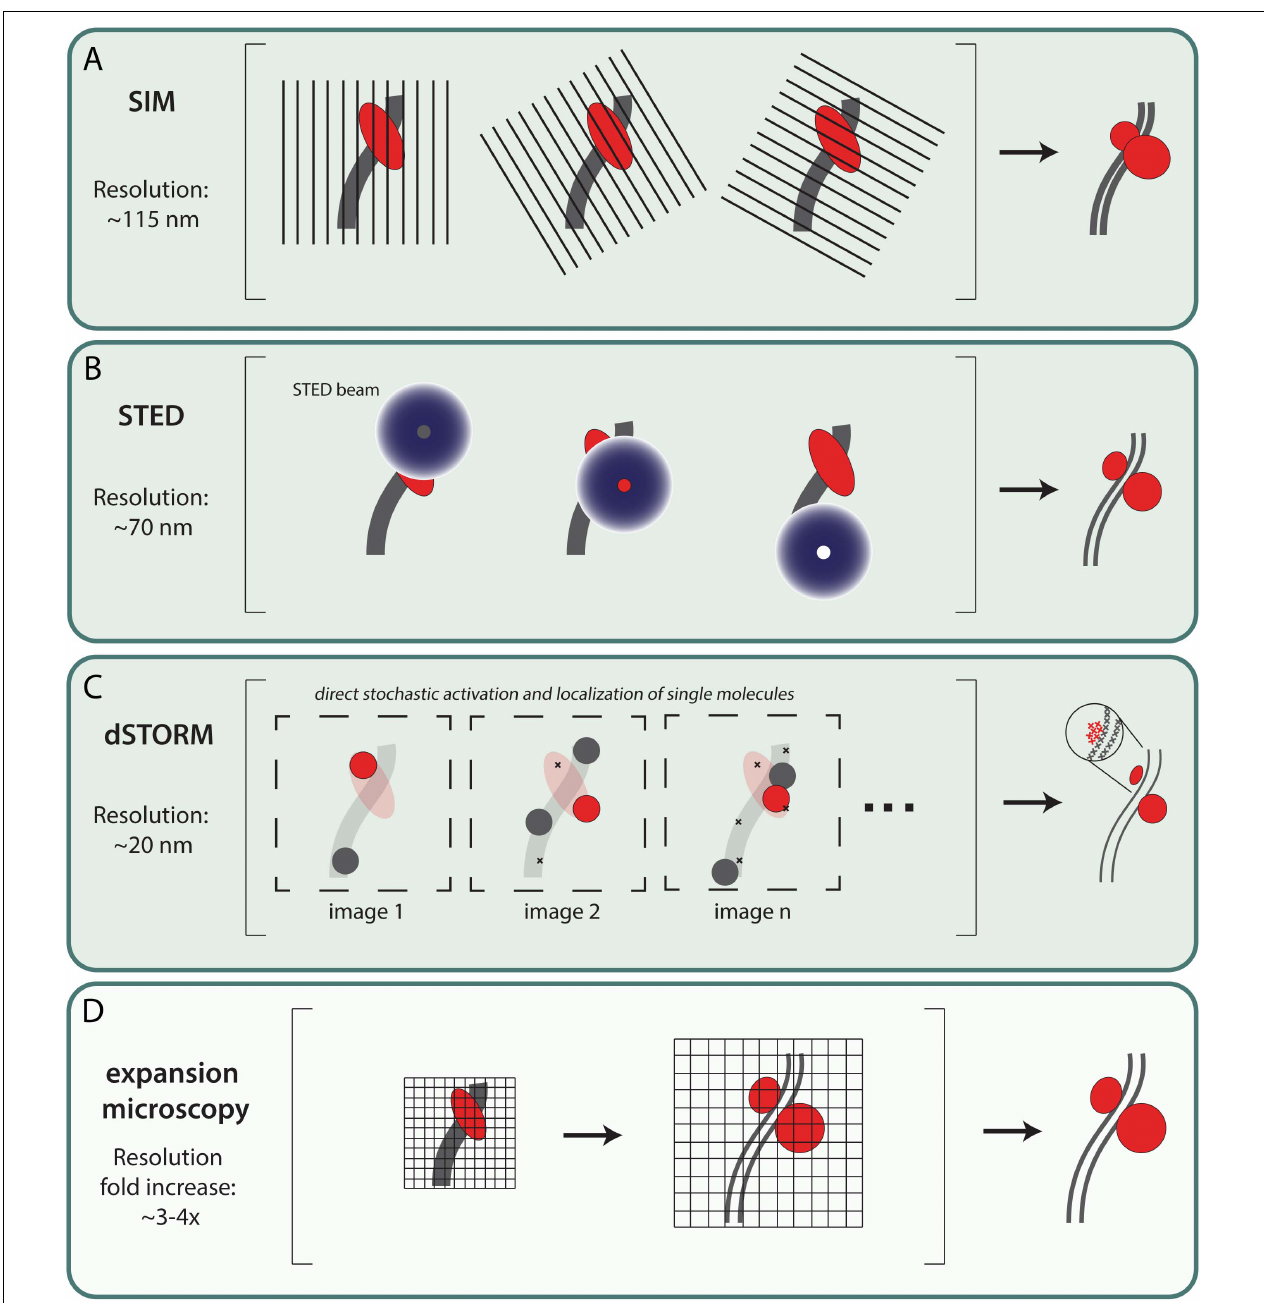
FIGURE 1 | Most commonly used fluorescent super-resolution microscopy techniques in meiosis research. (A) Structured illumination microscopy (SIM) – SIM uses a movable diffraction grating in combination with widefield microscopy. By exciting the sample and simultaneously translating and rotating the grid, an interference pattern—also called a Moiré pattern—occurs which contains more detailed information. Using mathematical tools these images are converted to one image with a lateral resolution up to ∼ 115 nm (Guerra, 1995; Gustafsson, 2000). (B) Stimulated emission depletion (STED) – In addition to the excitation laser, STED microscopy includes a second laser that generates a donut shaped STED beam of a longer wavelength that induces stimulated emission of any fluorophore that is not located at the center of the STED beam. This physically narrows the point spread function and therefore increases the lateral resolution up to ∼ 70 nm (Galbraith and Galbraith, 2011). (C) Direct Stochastic optical reconstruction microscopy(dSTORM) – dSTORM microscopy can provide high resolution images with a lateral resolution of ∼ 20 nm. Fluorophores are stochastically activated by increasing the switch between active and dark-state using an oxygen-reducing buffer and high laser